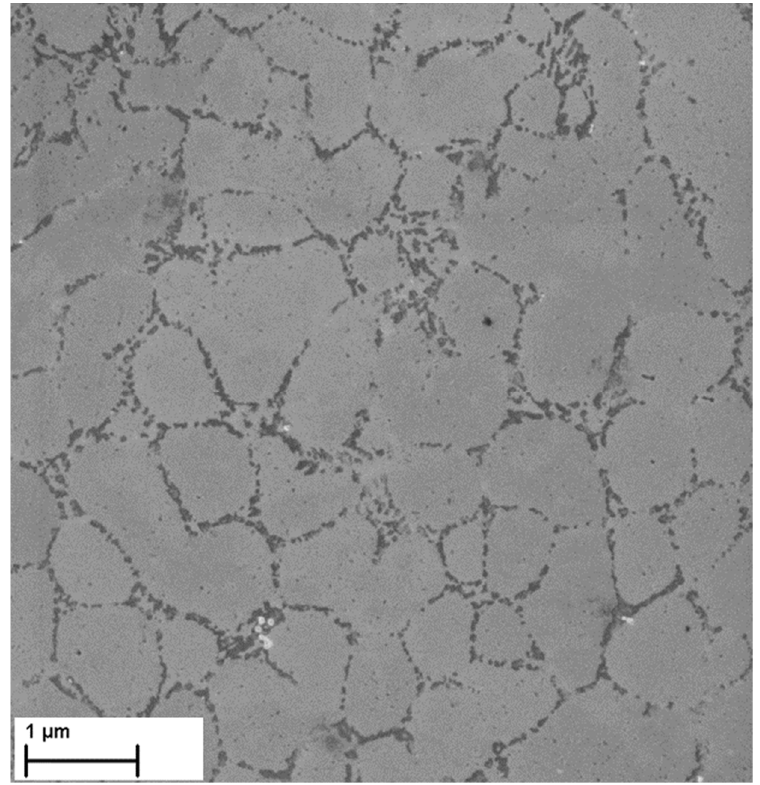
Figure A1. Microstructure of the alloy in the as-deposited state.